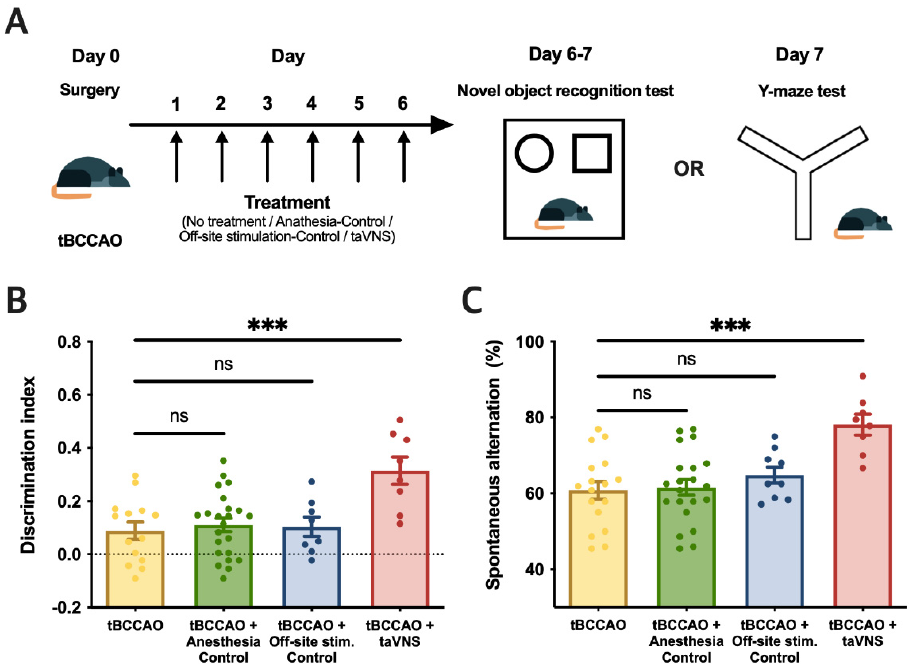
Figure 4. Impaired cognitive function was significantly restored after 6 phases of taVNS. ( A ) Experimental scheme. ( B ) In the NOR test, the discrimination index score of the taVNS treatment group (red, n = 8) significantly increased compared to the tBCCAO group (no treatment, yellow, n = 14; p < 0.001). The discrimination index scores of both the anesthesia control group (green, n = 23) and off-site stimulation control group (blue, n = 8) were not different from the tBCCAO group. ( C ) In the Y-maze test, the spontaneous alternation rate of the taVNS treatment group (red, n = 8) was significantly higher than that of the tBCCAO group (no treatment, yellow, n = 17; p < 0.001). The spontaneous alternation rates of both the anesthesia control group (green, n = 21) and off-site stimulation control group (blue, n = 9) were not different from the tBCCAO group. The error bars indicate the SEM. One-way ANOVA with the post hoc Dunnett test was used. *** p < 0.001; ns, not